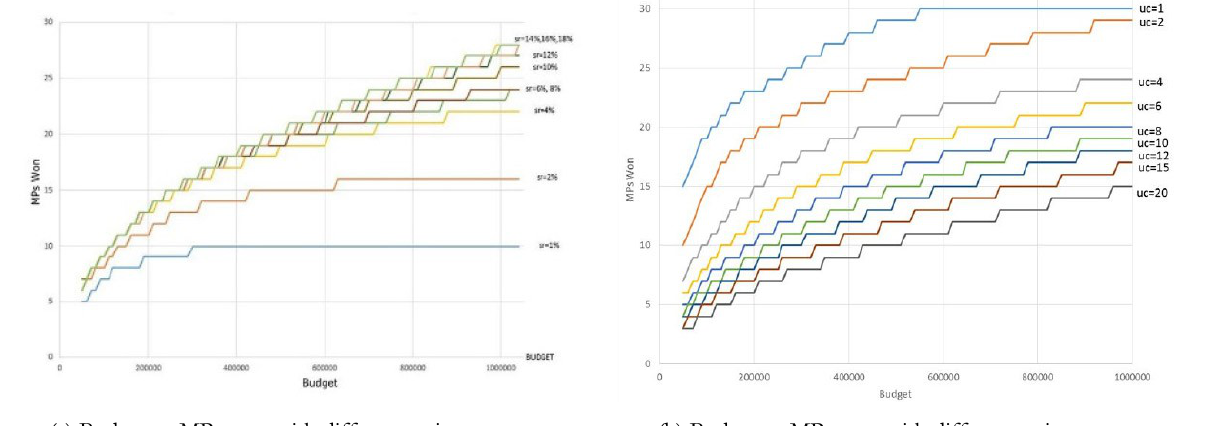
Figure 1. Effect of Budget on MPs won